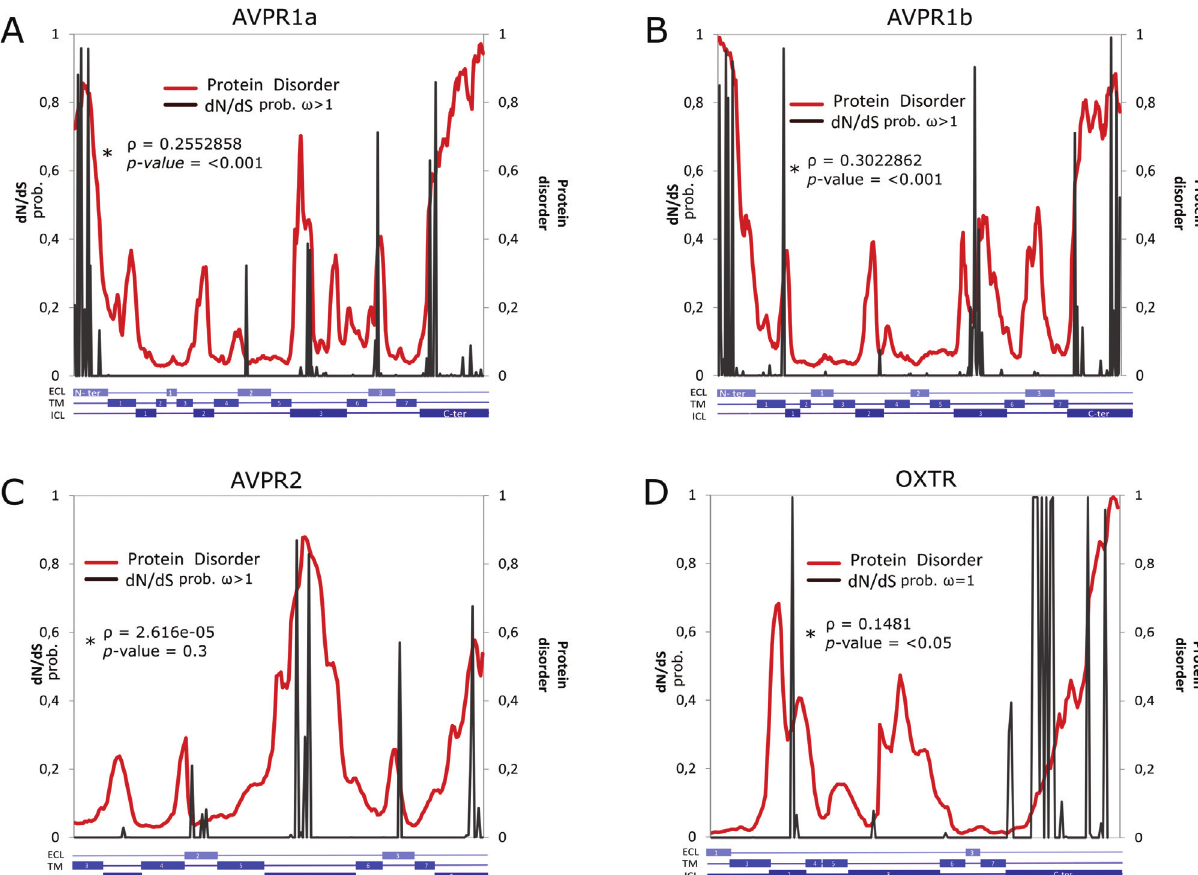
Figure 2 - Bayes Empirical Bayes analyses. The probability of (cid:2) > 1 (sites under positive selection and/or relaxed constraint; A-C) or probability of (cid:2) = 1 (sitesunderneutralityand/orrelaxedpurifyingselection;D)isshowningray.Disorderdegree(red)estimatedforeachresidueof Homosapiens AVPR1a (A), AVPR1b (B), AVPR2 (C), and OXTR (D). ECL: Extracellular; TM: Transmembrane; ICL: Intracellular. Patterns similar to those of other mamma- lian species were obtained (Table 3). (cid:2) = nonsynonymous/synonymous rate ratio. *Rho= Correlation between disorder value and the probability of being under positive selection or relaxed constraint.